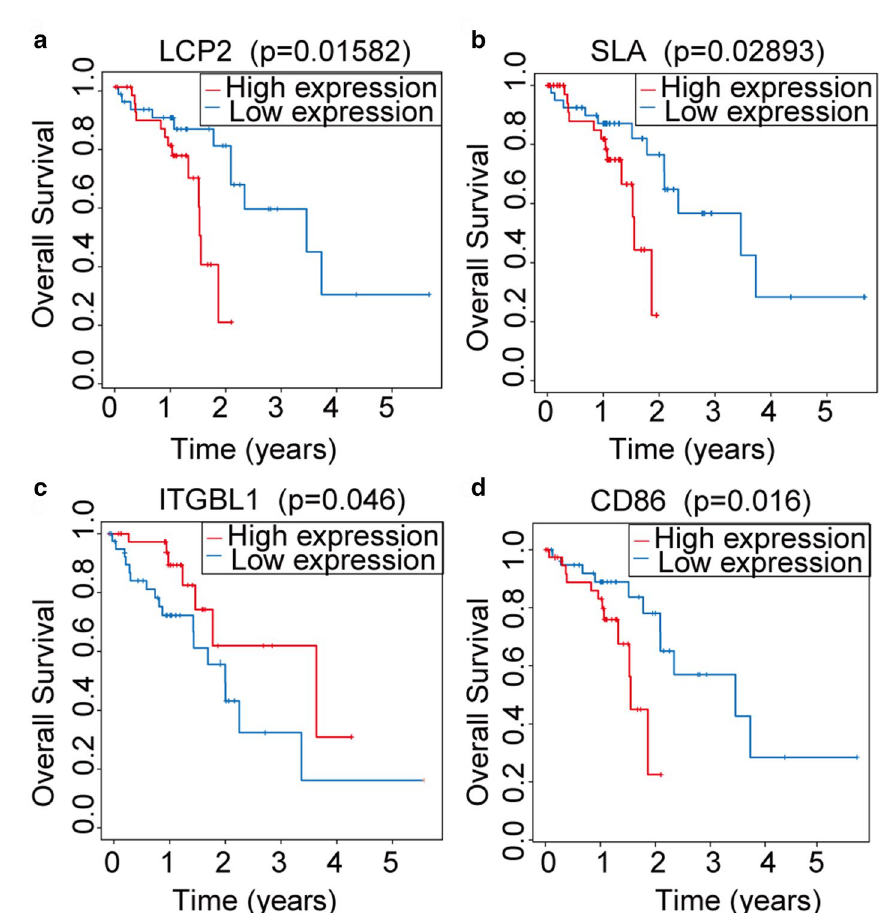
Fig. 6 Kaplan–Meier curves with log-rank test were performed for the prognosis- related genes in ceRNA